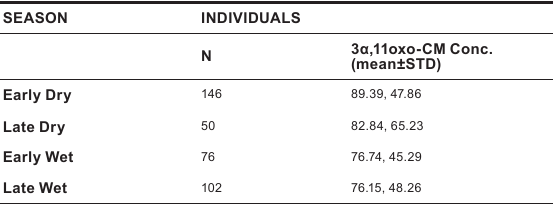
Table 2 N, mean, standard deviation (concentrations of faecal glucocorticoid metabolites (ng/g WW)) in the four ecological seasons (age classes combined) for free-ranging family herds of elephants in KNP from May 2002 to August